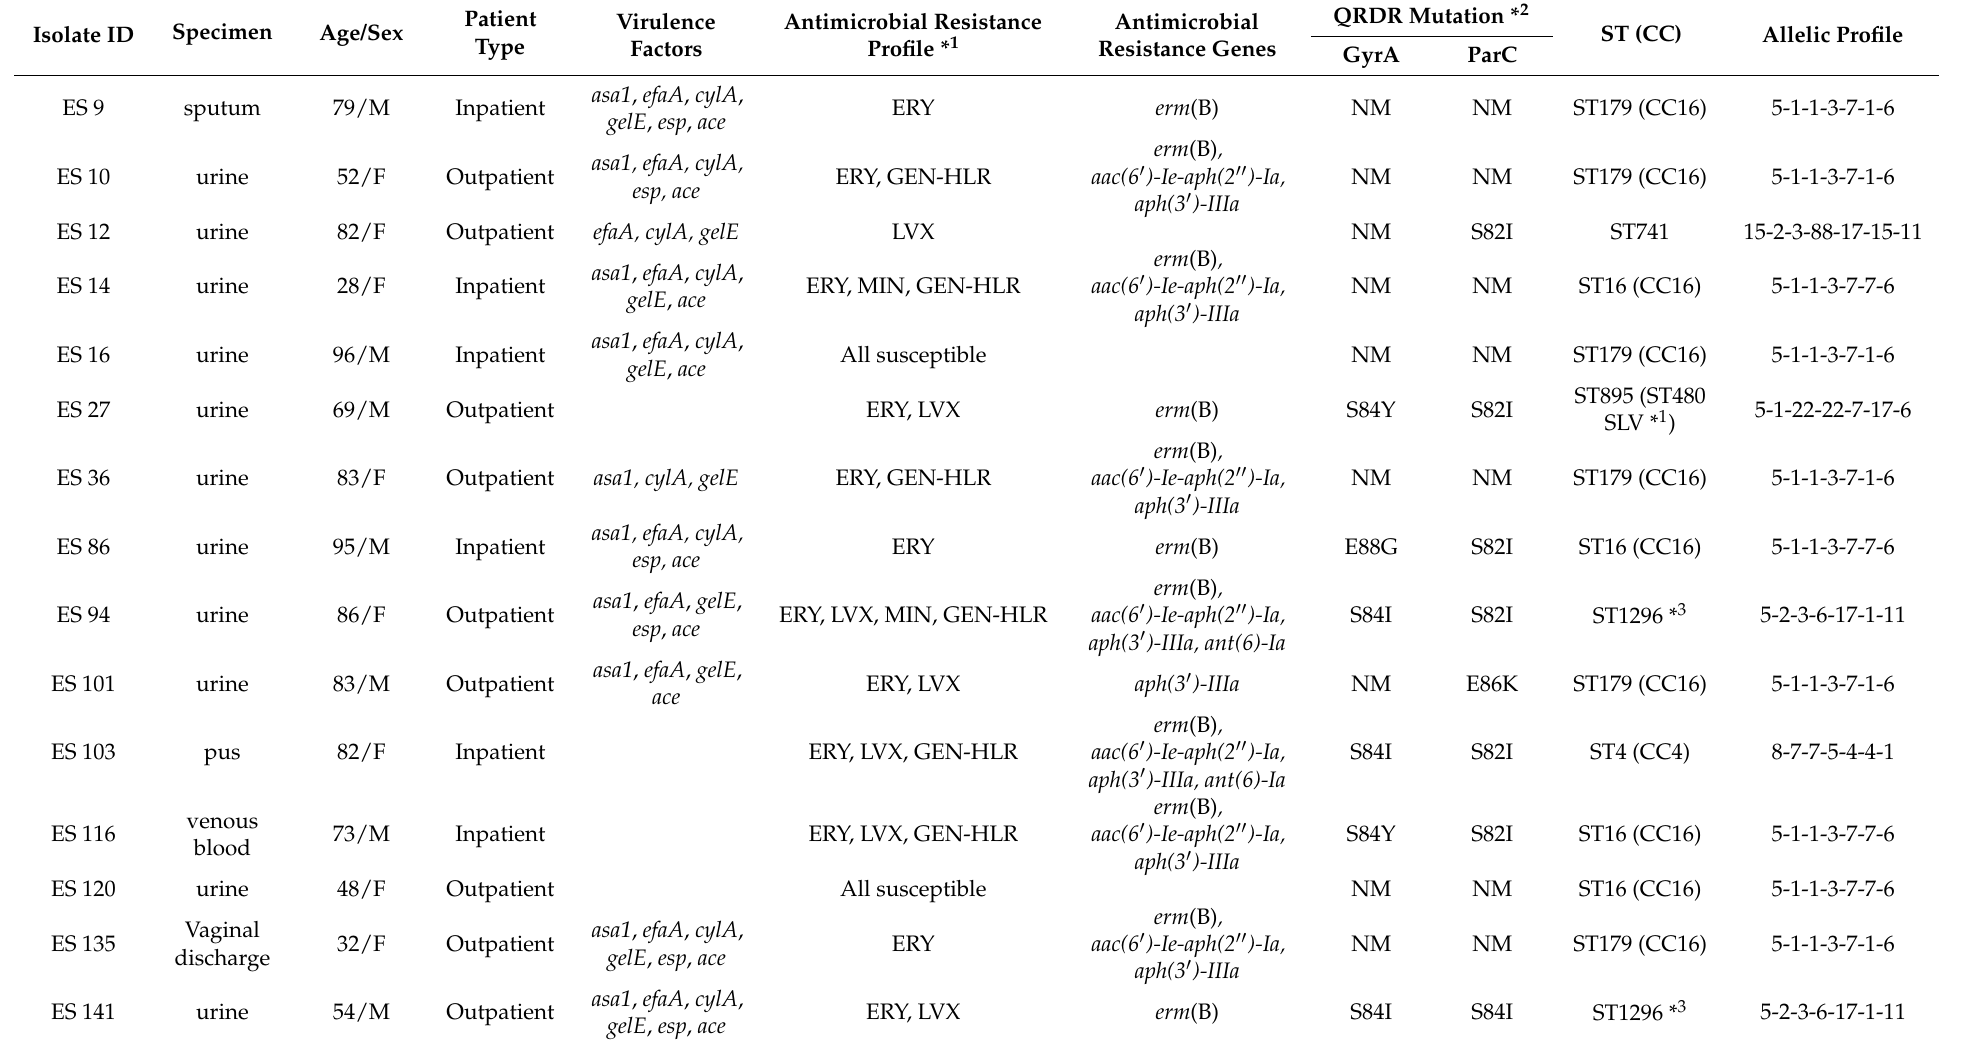
Table 4. Genotypes, virulence factors and antimicrobial resistance profile of selected E. faecalis isolates (n =